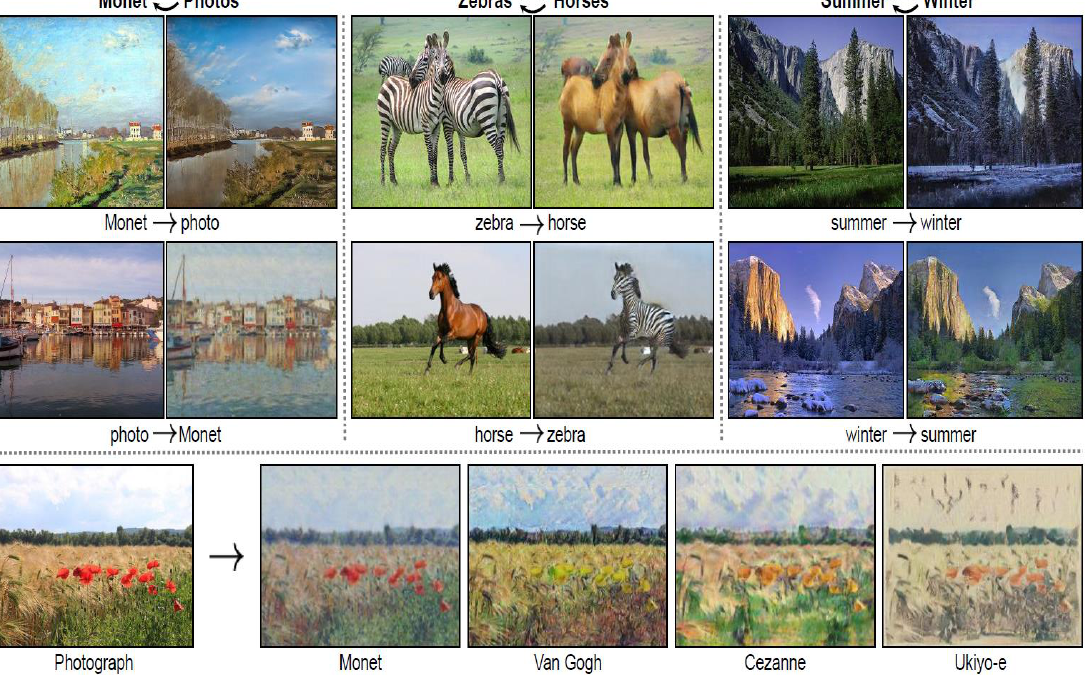
Figure 6. Artistic style transfer using cycle-consistent adversarial networks [28].